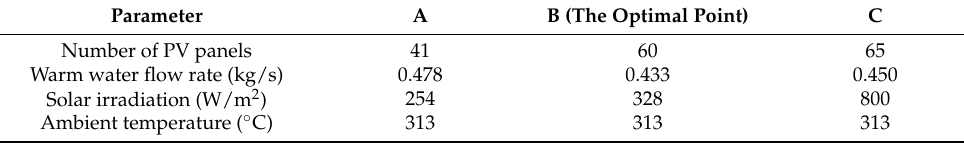
Table 5. Optimal parameters at points A, B, and C in the optimal Pareto front.